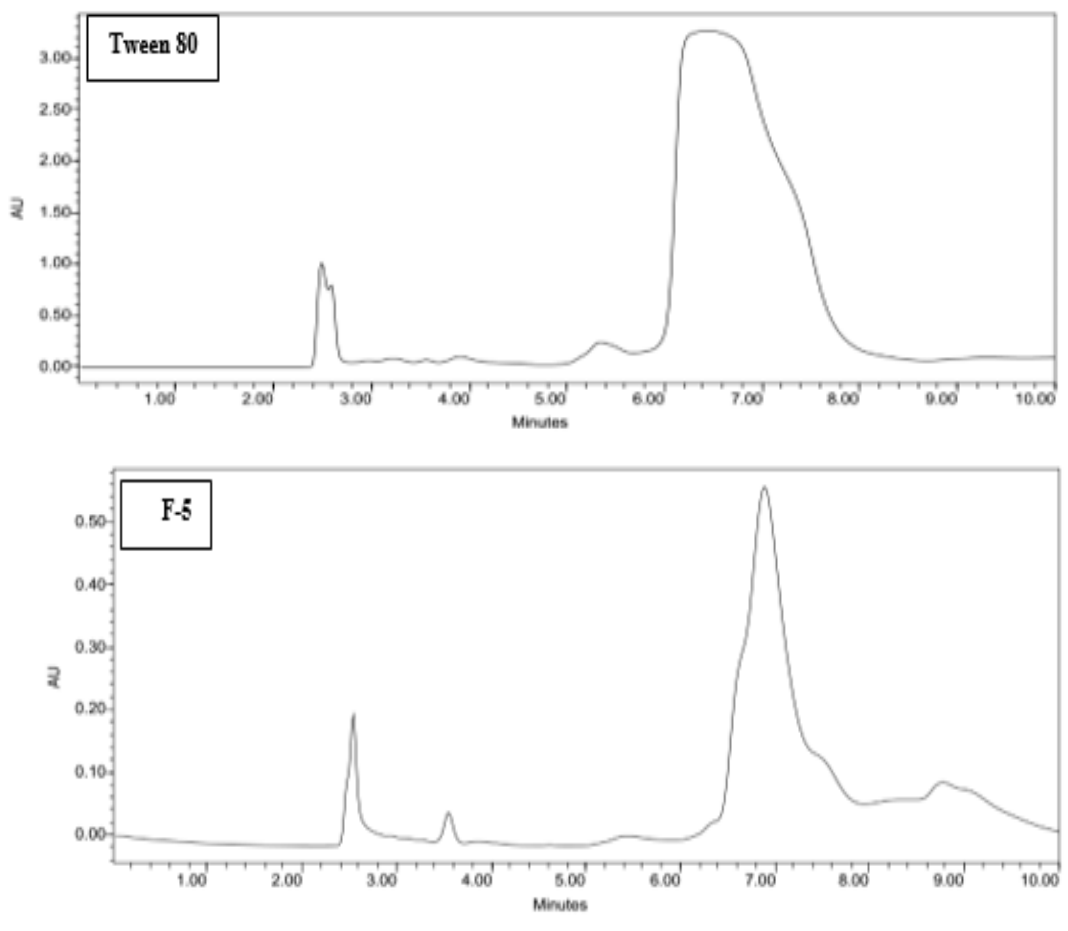
Figure 14. Chromatograms of tween80 and F-5 respectively